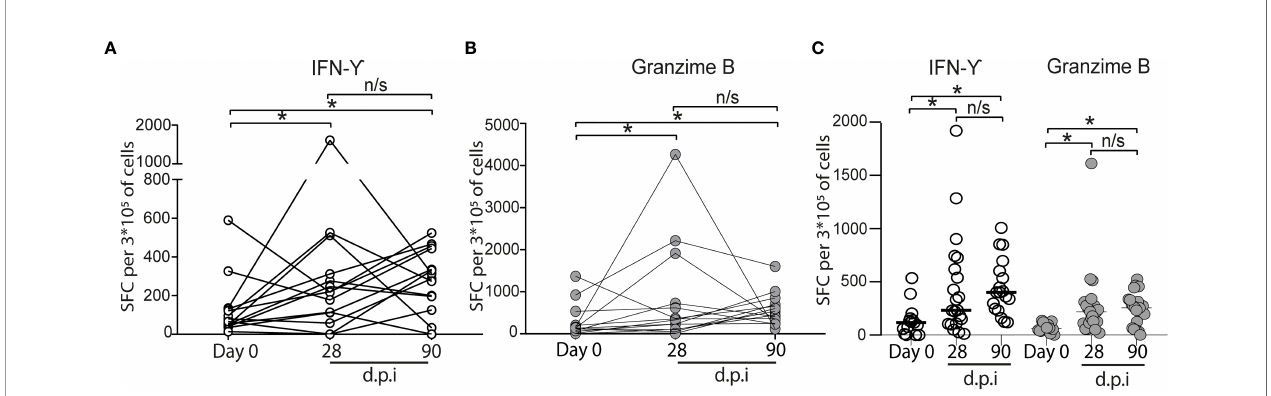
FIGURE 4 | Cytokine secreting cells of vaccinated volunteers in vitro induced by SARS-CoV-2 S protein. (A) IFN- g ( ○ ). (B) Granzyme ( (cid:129) ). The number of ELISPOT- forming cells (SFC) per 3 × 10 5 was quantitated in PBMC, obtained before vaccination (indicated as "Day 0"). Twenty-eight and 90 days after the second immunization (dpi) ( n = 15 volunteers), the data show individual paired values. (C) Total data from 21 volunteers (same volunteers from (A, B) and others with no sample on some of the time points evaluated) were graphed and shown with median for IFN- g ( ○ ) and Granzyme ( (cid:129) ). Asterisk (*) represents statistically signi fi cant difference ( p < 0.05) obtained from the comparison against Day 0. n/s indicates non-signi fi cant